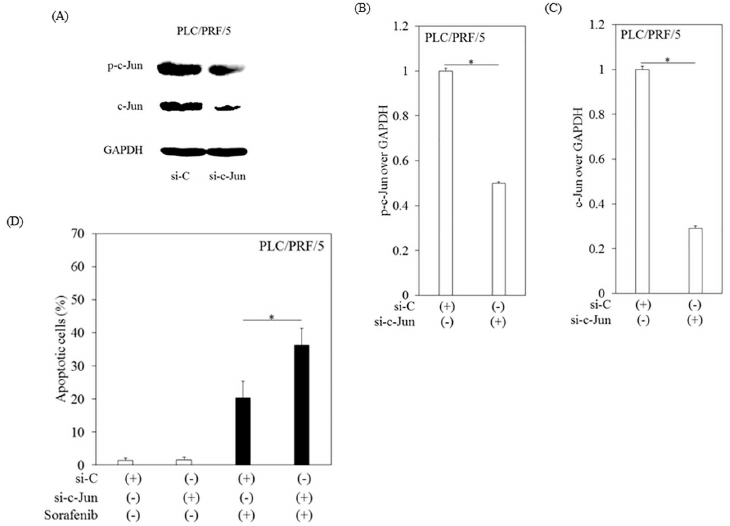
Fig 4. Knockdown of c-Jun enhanced sorafenib-induced apoptosis in human hepatoma PLC/PRF/5 cells. (A)-(C) Validationof siRNAs si-c-Jun and si-control (si-C). Lysates from transfected cells were immunoblotted with antibodies againstp-c-Jun, c-Jun or GAPDH. GAPDH was used as internalcontrol. Densitometric analyseswere performed with ImageJ software. Data are presented as mean ± SD of triplicate samples. (D) Apoptosisin PLC/PRF/5 cells treated with or without 7.5 μ M sorafenib for 48 hours after transfectionwith each siRNA. Apoptosis was determinedby an APOPercentage apoptosisassay (Biocolor). (B, D) Densitometric analyseswere performed with ImageJ software. Data are presented as mean ± SD of triplicate samples. * p < 0 . 05 betweentwo groups.